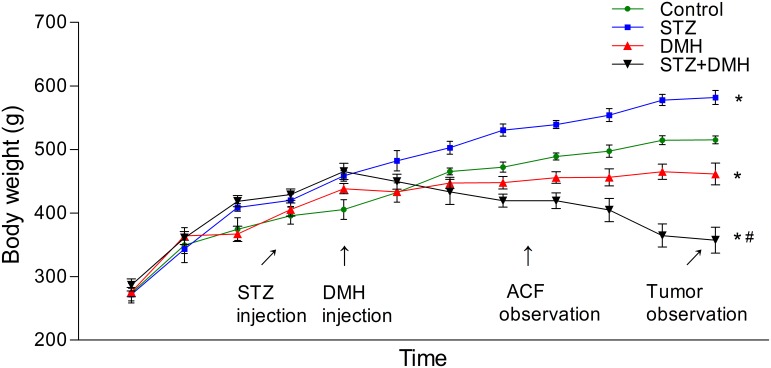
Body weight of rats throughout the entire experiment.Values are expressed as mean ± S.E.M. and analyzed using unpaired student’s T test at P<0.05. At the conclusion of the experiment, *P<0.05 vs. Control group. #P<0.05 vs. DMH group.